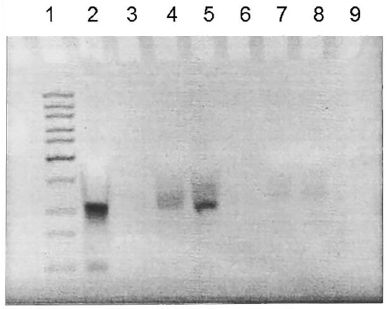
Figure 2. Gel electrophoresis of CPP-AuNP complexes with different oligonucleotide/gold weight- to-weight ratios: 1–10 bp DNA ladder; 2–free oligonucleotide; 3–empty lane; 4–1/10; 5–1/20; 6–1/30; 7–1/40; 8–1/80; 9–empty lane.